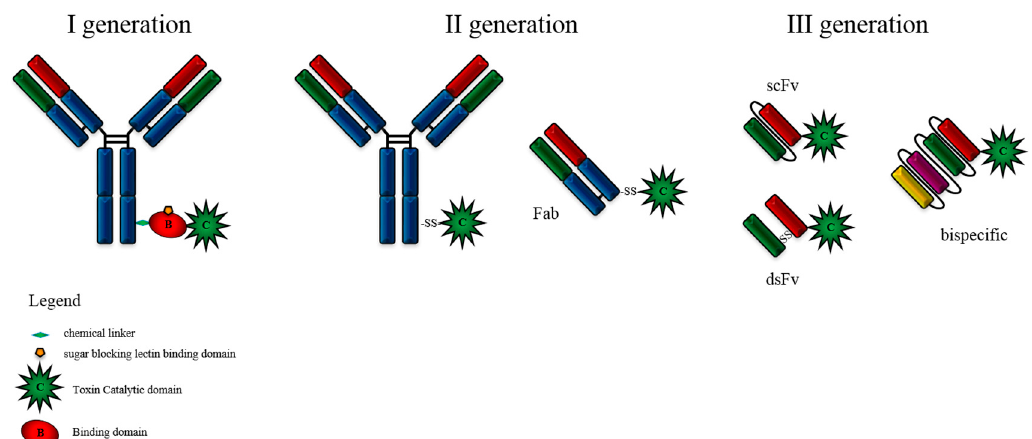
Figure 2. Development of immunotoxins for targeted therapy. Three generations of immunotoxins (Its) are displayed. First generation ITs were prepared by chemically conjugating antibodies to intact toxin with attenuated cell binding capability. In the second generation ITs, truncated toxins lacking binding domain were conjugated to the antibody antigen-binding fragment (Fab). Third generation ITs were produced through genetic engineering and the targeting moieties are represented by the light and heavy chain variable fragments either genetically linked (single-chain variable fragment - scFv) or held together by a disulphide bond (dsFv). Bispecific ITs contain two monodomains with different specificities.